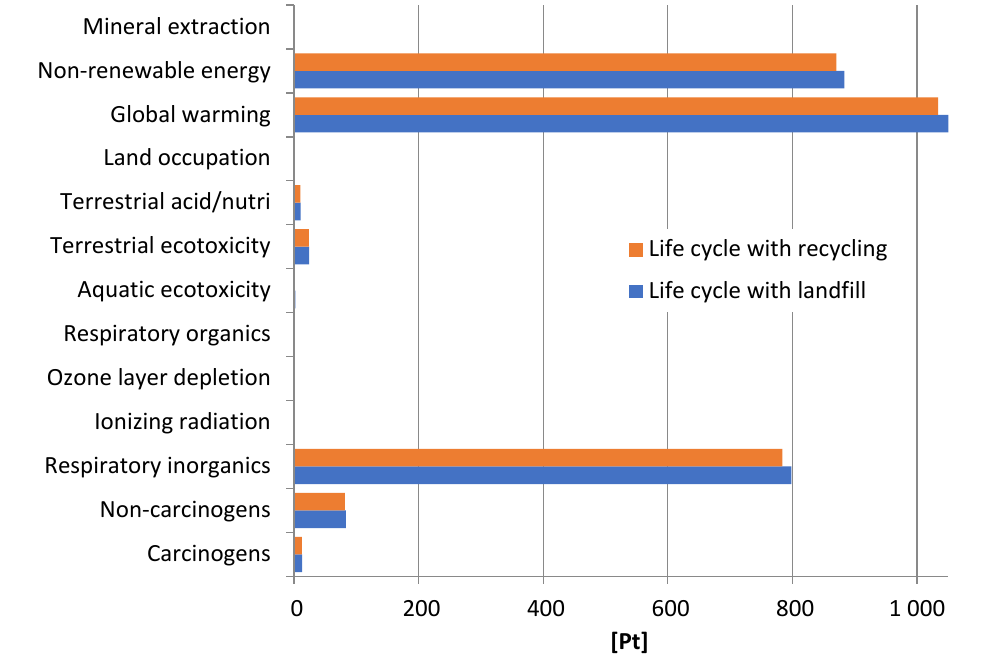
Figure 9. The results of grouping and weighing the environmental consequences occurring in the life cycle of the research object by the form of post-use development and the impact categories.